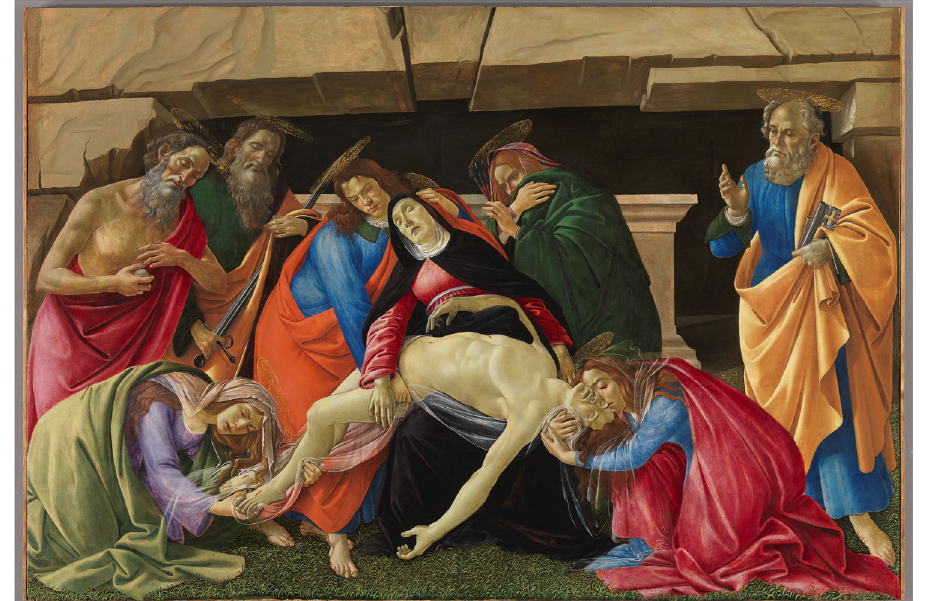
Fig.1|SandroBotticelli, TheLamentationofChrist ,c.1490/95,140×209.2cm, Bavarian State Painting Collections, Inv. No. 1075. Although the fl esh and some draperies are painted in egg tempera, the grass foreground and the stone tomb